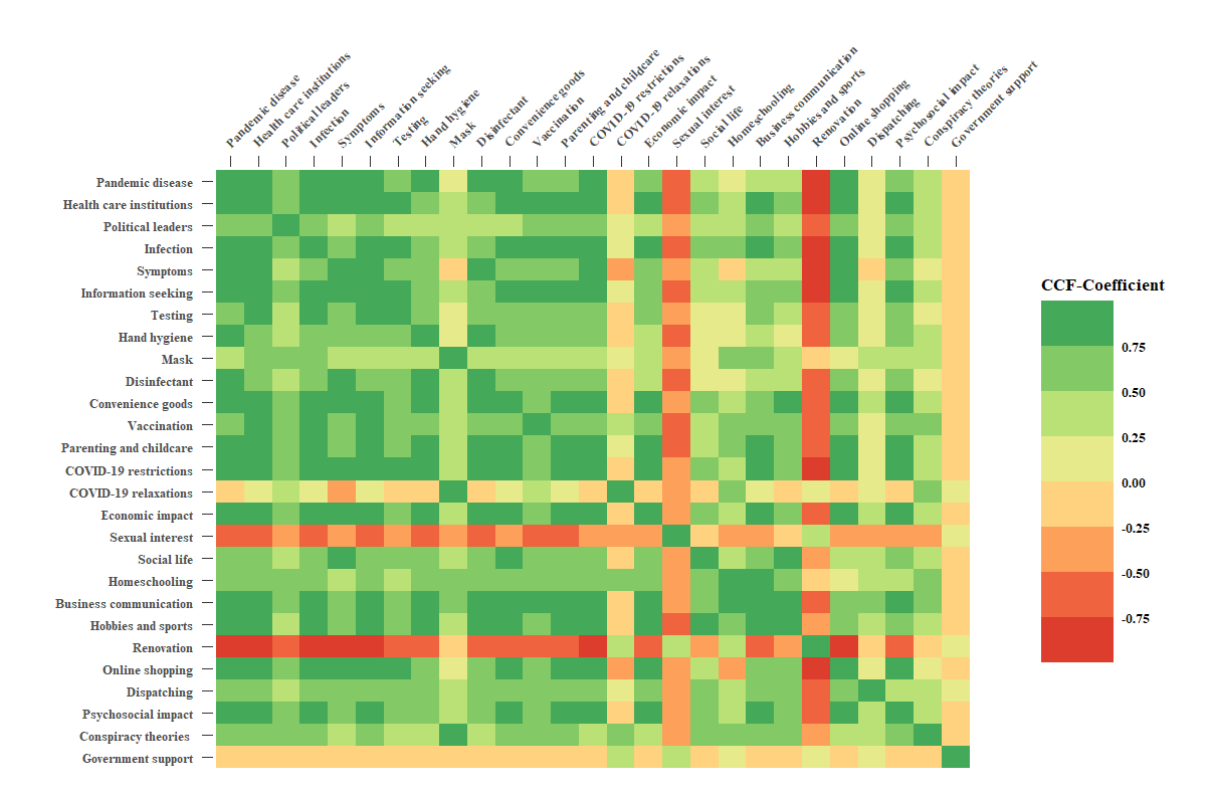
Figure 1. Heat map of cross-correlations for all 27 domains for Germany only. The lower triangle shows concurrent cross-correlations. The upper triangle shows maximal correlations obtained when the time series of one domain was shifted across a range from 0 to 21 days relative to the time series of the corresponding other domain. CCF: cross-correlation